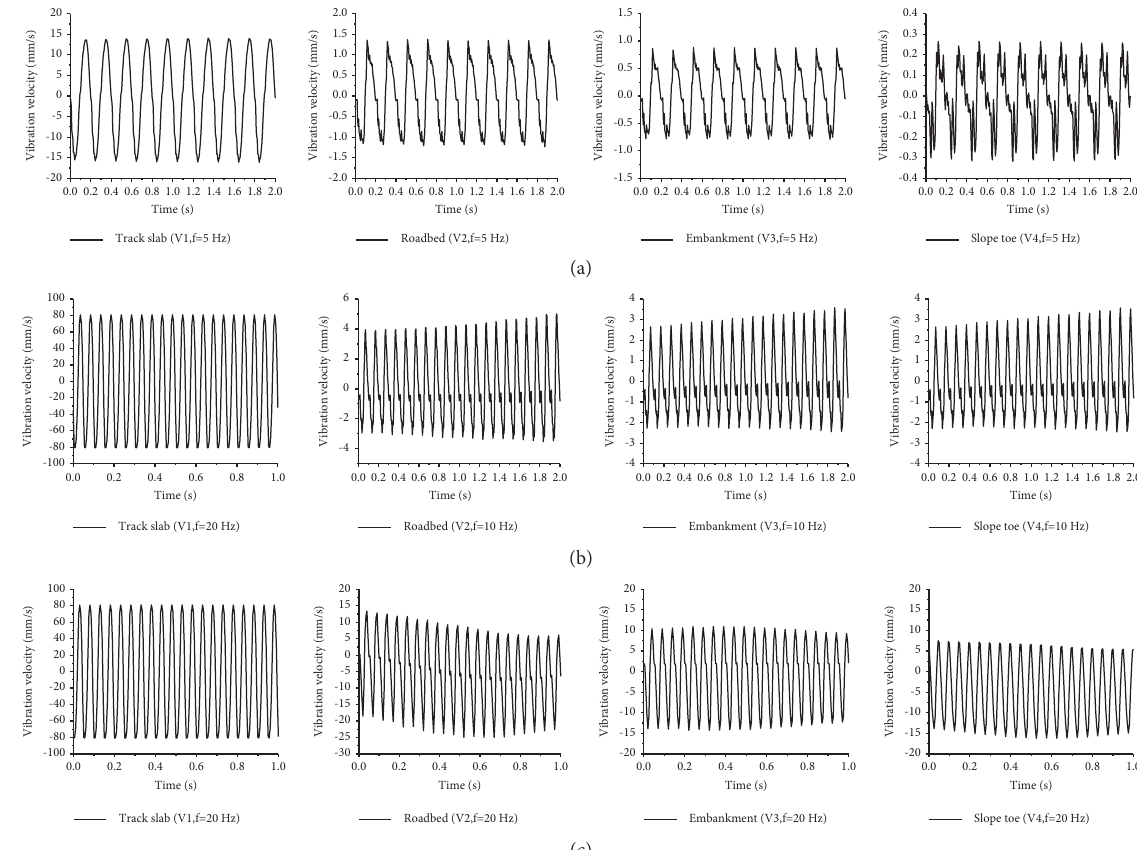
Figure 7: Time history curves of vibration velocity at track slab, roadbed, embankment, and slope toe. (a) f � 5Hz. (b) f � 10Hz. (c) f �